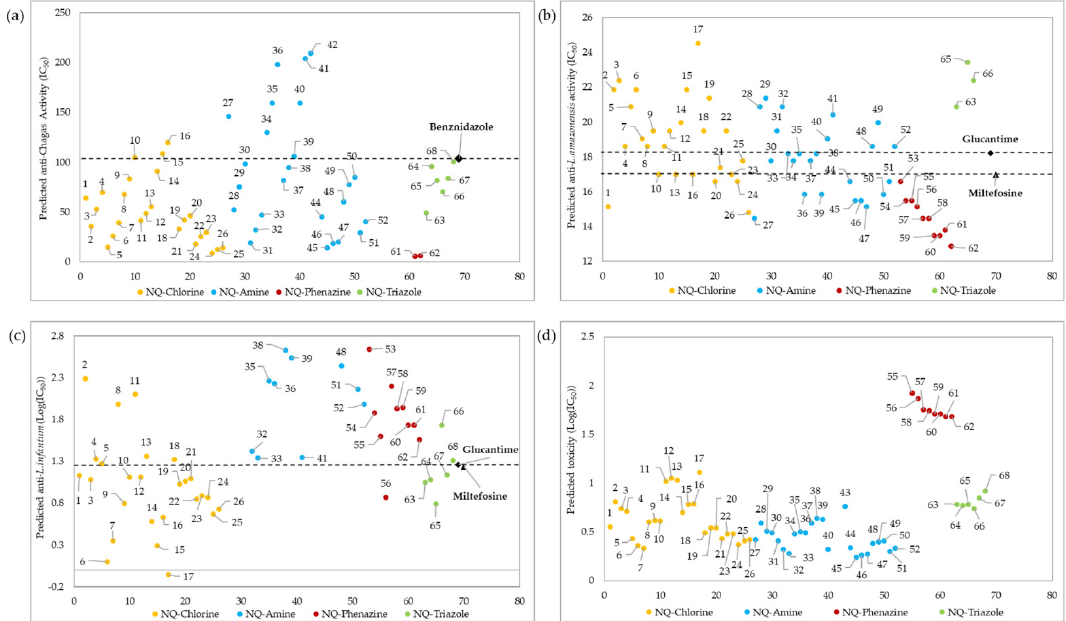
Figure 5. Prediction of anti-chagas (IC 50 ) (Table S6) ( a ), anti- L. amazonensis (IC 50 ) ( b ), and anti- L. infantum (LogIC 50 ) (Table S12) ( c ) activity, as well as toxicity (LogIC 50 ) (Table S16) ( d ), for the 68 1,4-naphthoquinone derivatives ( x -axis) evaluated using QSAR Equations (1)–(4), respectively. Only structures with reliable activity, as determined by the influence value ( h* ), are presented. The predicted values for anti- L. infantum and toxicity are presented in LogIC 50 because of the wide dispersion of the data. The predicted IC 50 values of anti- Leishmania activity ( L. amazonensis and L. infantum )